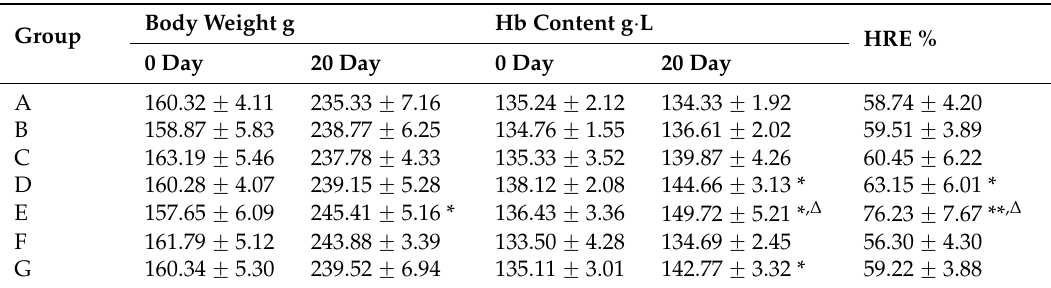
Table 5. Body weight, hemoglobin (Hb) content and haemoglobin regeneration efficiency (HRE)